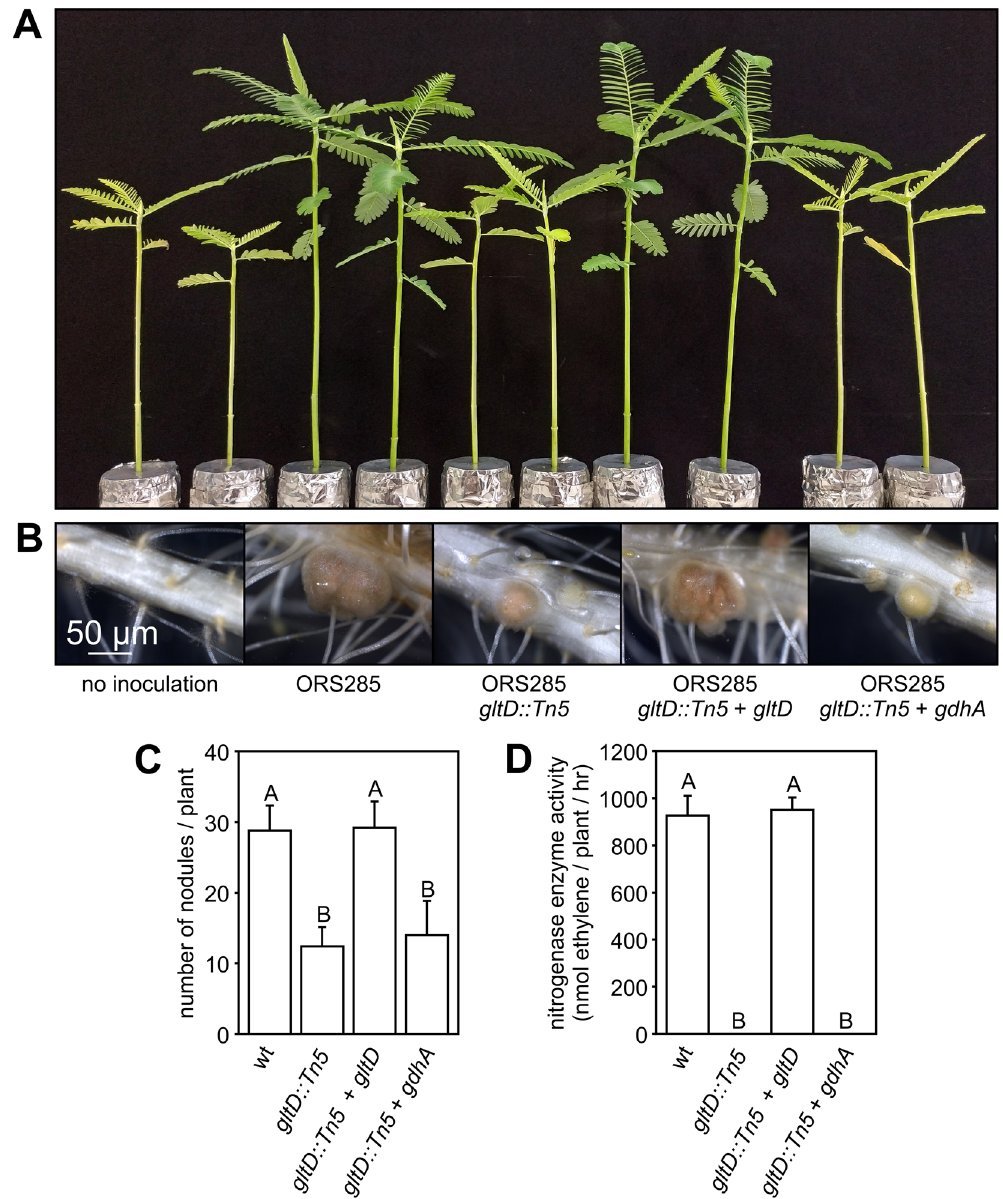
Figure 7. The Bradyrhizobium ORS285 gltD::Tn5 mutant does induce nodules on Aeschynomene afraspera (LSTM #1) plants. ( A ) Comparison of the growth of A. afraspera plants inoculated with ORS285, ORS285 gltD::Tn5 , ORS285 gltD::Tn5 + gltD , and ORS285 gltD::Tn5 + gdhA . Non-inoculated plants (ni) were used as control. ( B ) Roots of A. afraspera plants inoculated with ORS285, ORS285 gltD::Tn5 , ORS285 gltD::Tn5 + gltD , and ORS285 gltD::Tn5 + gdhA . ( C ) Number of root nodules on A. afraspera plants inoculated with ORS285, ORS285 gltD::Tn5 , ORS285 gltD::Tn5 + gltD , and ORS285 gltD::Tn5 + gdhA , respectively. The mean number of nodules per plant (n = 5) at 21 dpi is presented. ( D ) Acetylene reducing activity of A. afraspera plants inoculated with ORS285, ORS285 gltD::Tn5 , ORS285 gltD::Tn5 + gltD , and ORS285 gltD::Tn5 + gdhA at 21 dpi. The mean amount of produced ethylene per hour and per plant (n = 5) is indicated. In ( C ) and ( D ) error bars represent standard errors of the mean and letters represent conditions with significant difference according to the Tukey’s test (P <